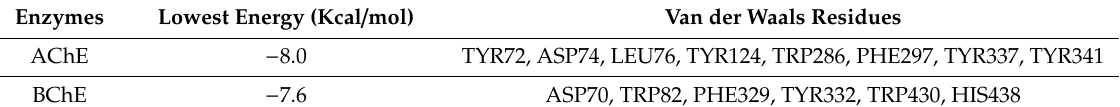
Table 3. The molecular interaction of cholinesterases with zerumbone.